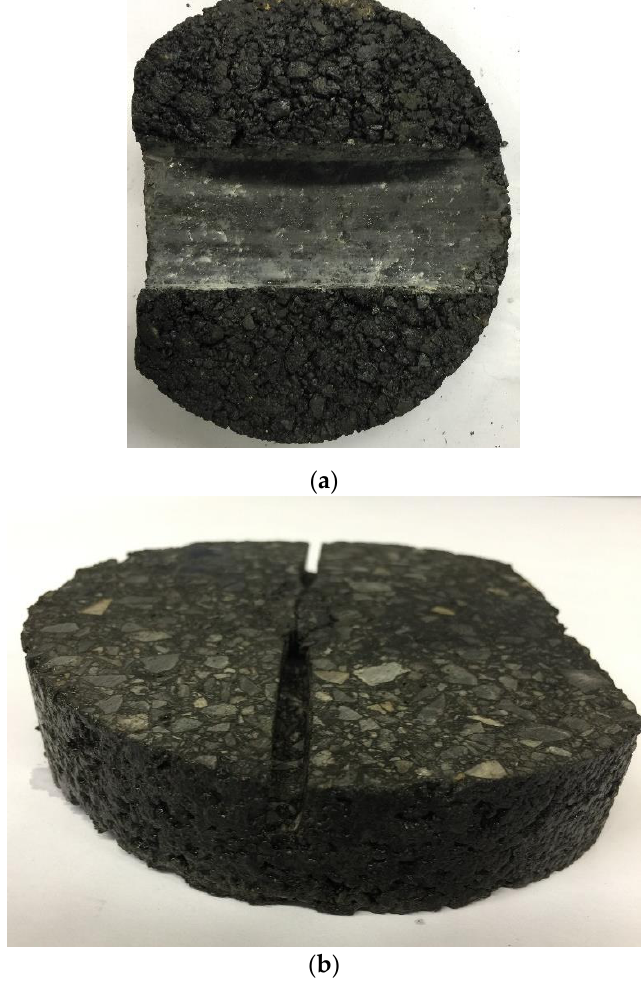
Figure 10. Specimens #5 and #6 (1-inch thickness, 5 days aging, with a notch), ( a ) specimen top and ( b ) specimen bottom.